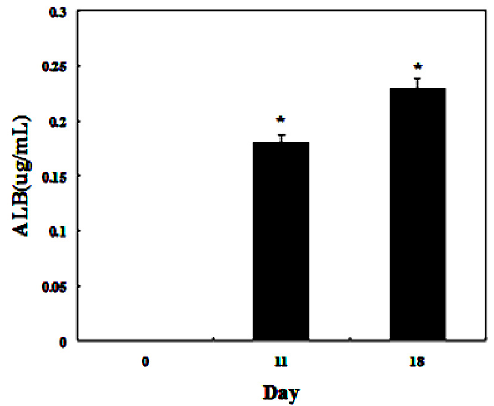
Figure 9. Functional analysis using enzyme-linked immunosorbent assay (ELISA). ELISA analyses showed that differentiated AD-MSCs could secrete albumin. * p <